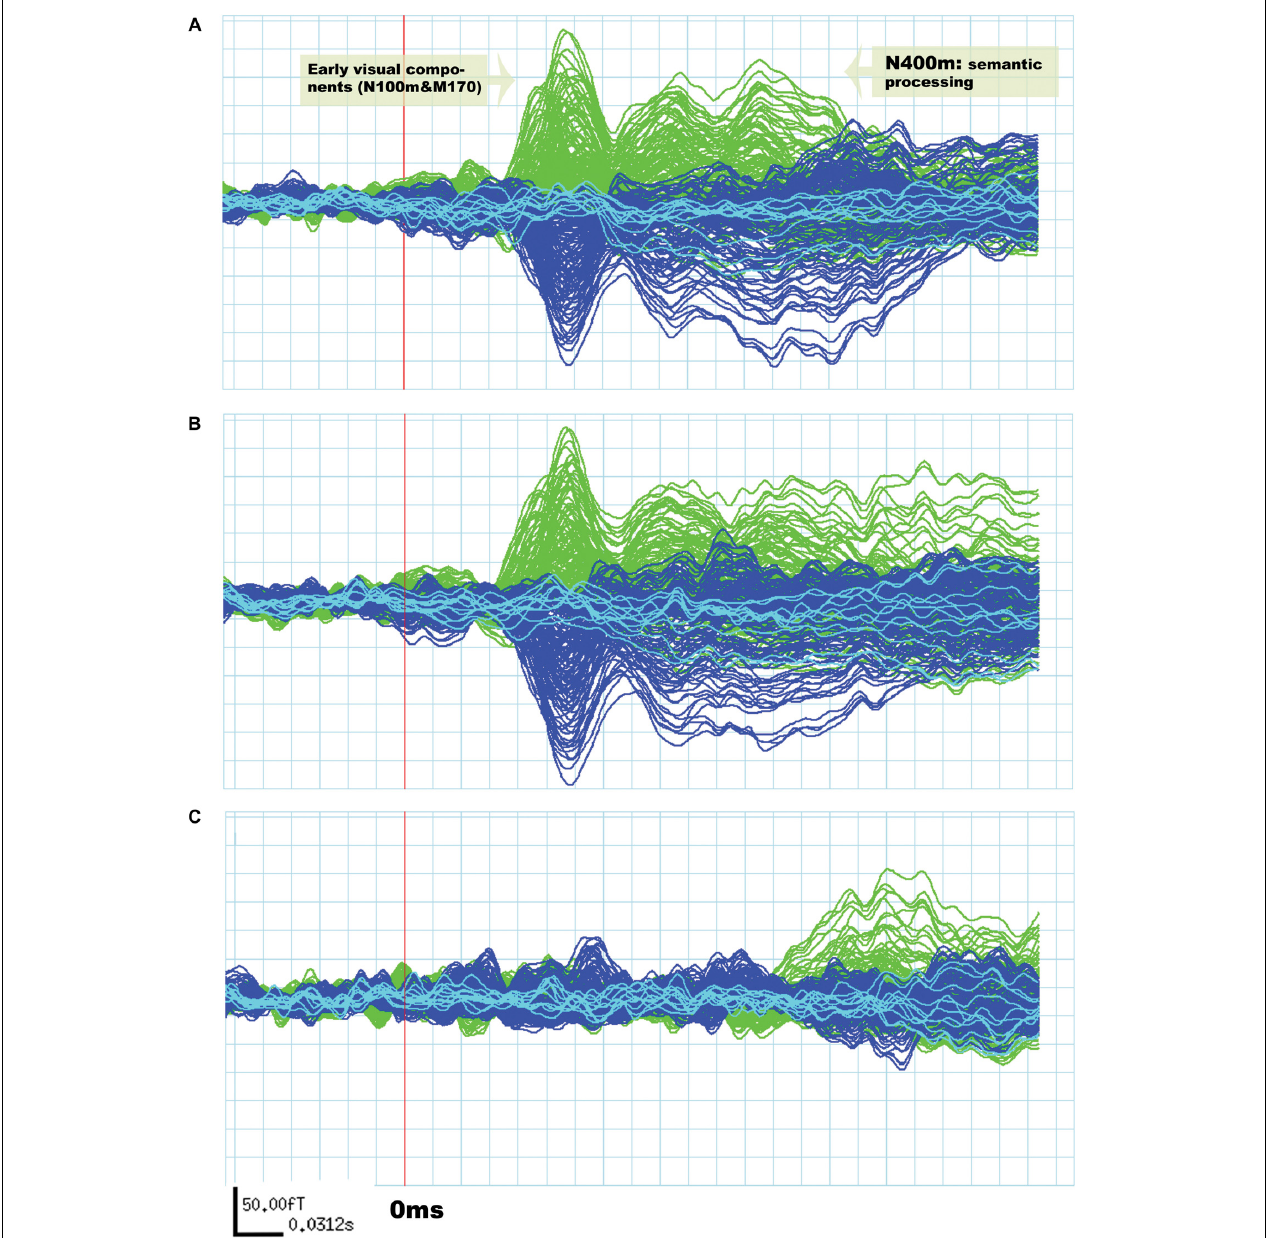
FIGURE 1 | Evoked response field from MEG signals related to silent reading of word pairs in a single subject. The signals in green are derived from the left hemisphere sensors and the signals in blue are from the right hemisphere. In (A) the “unrelated” condition and in (B) the “related” condition. Early visual components (N100m and M170) are not significantly different between “unrelated” and “related” conditions. The signal in (C) is a subtraction of the “unrelated” condition from the “related” condition. number of trials in the 4 test blocks (240 trials). Late responses were counted as